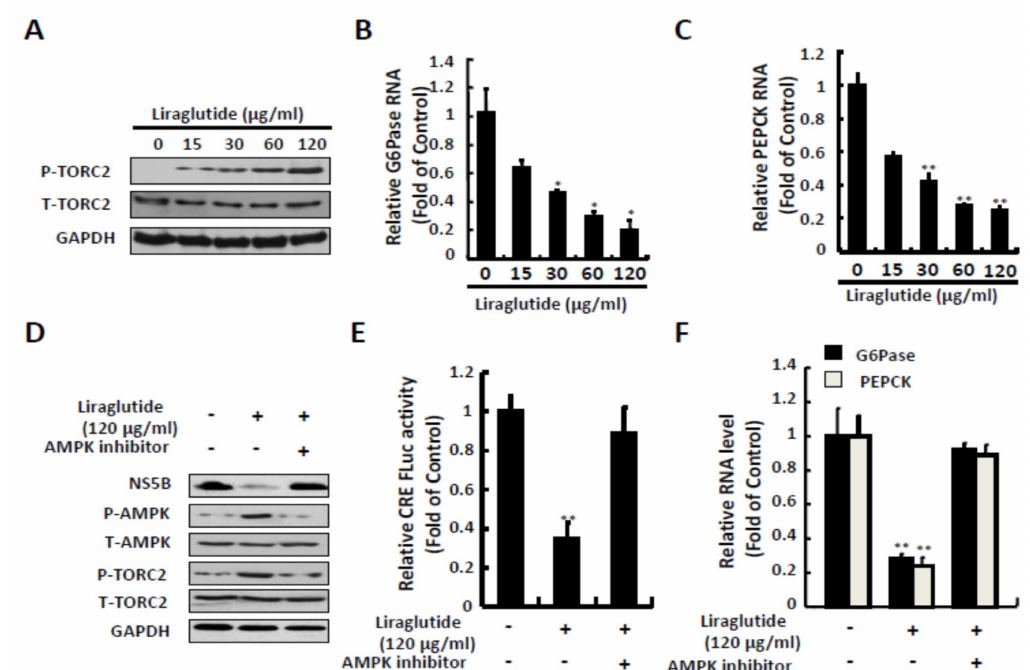
Figure 4. E ff ects of liraglutide on TORC2 phosphorylation and gluconeogenesis genes expression. ( A , B , C ) Liraglutide activated TORC2 phosphorylation and suppressed G6Pase and PEPCK expressions in Ava5 cells. Ava5 cells were treated with liraglutide with indicated concentrations for 3 days. ( D ) AMPK inhibitor attenuated liraglutide-induced TORC2 phosphorylation. Ava5 cells were treated with liraglutide (120 µ g / mL) combined with AMPK inhibitor (Compound C) for 3 days. ( E , F ) AMPK inhibitor attenuated liraglutide-reduced CRE transcription activity and G6Pase and PEPCK expressions. Ava5 cells were transfected with pCRE-FLuc reporter plasmid (1 µ g) and treated with liraglutide (120 µ g / mL) combined with AMPK inhibitor (Compound C) for 3 days. The cell lysate was extracted and the protein synthesis was analyzed by Western blot using anti-Phospho-TORC2, anti-TORC2, anti-HCV NS5B, anti-AMPK, anti-phospho-AMPK, and anti-GAPDH (loading control) antibodies, respectively. The total RNA was extracted and intracellular G6Pase and PEPCK RNA levels